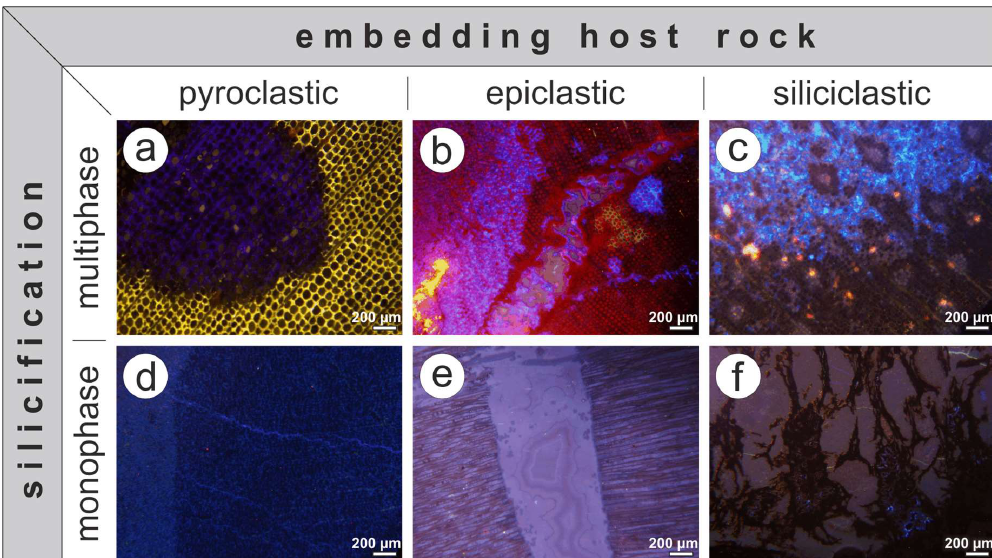
Figure 14. CL types of anatomically preserved (silicified) wood from the late Paleozoic of Central Europe based on [29–31,74], and this study. ( a ) Multiphase-pyroclastic type (K4815 from Chemnitz). Note replacement of primary yellow/red CL by blue CL. ( b ) Multiphase-epiclastic type (K6556 from Winnweiler). Note the reduced anatomical preservation in areas of blue CL. ( c ) Multiphase-siliciclastic type (K2097 from the Kyffhäuser). Note the generally low preservation quality and yellow CL of the initially silicified wood. ( d ) Monophase-pyroclastic type (K6573 from Flöha). ( e ) Monophase-epiclastic type (K6404 from Winnweiler). Note the homogeneous, initially blue CL. ( f ) Monophase-siliciclastic type (K6561 from Crock).